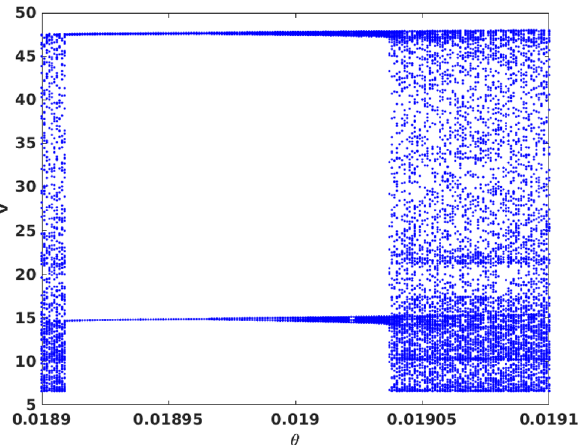
Figure 9. Bifurcation diagram of prey populations with respect to Allee parameter, in the range θ ∈ [ 0.0189 : 0.0191 ] . Here we display the local maxima of the prey population. The parameter values in Eq. (1) are as mentioned in the text.